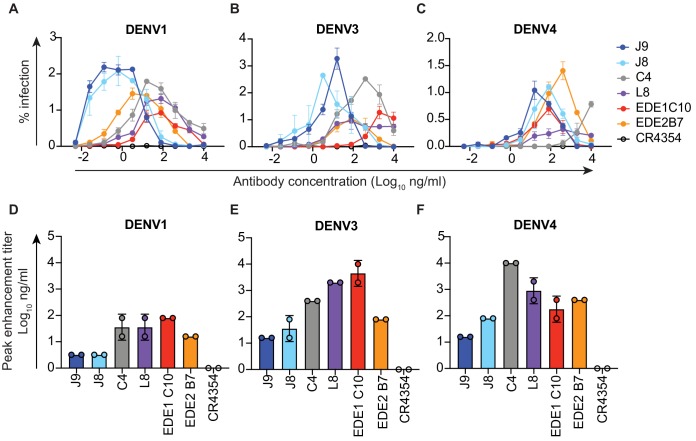
ADE of DENV1, DENV3, and DENV4 infection.Serial dilutions of the indicated antibodies were pre-incubated with (A) DENV1, (B) DENV3 or (C) DENV4 reporter virus prior to infection of K562 cells. Data points and error bars indicate the mean and range of infection in duplicate wells, respectively. Bar graphs represent average antibody concentrations at peak enhancement of (D) DENV1, (E) DENV3 or (F) DENV4 infection obtained from two independent experiments, each represented by a data point. Where indicated, error bars represent the range in panels D-F.